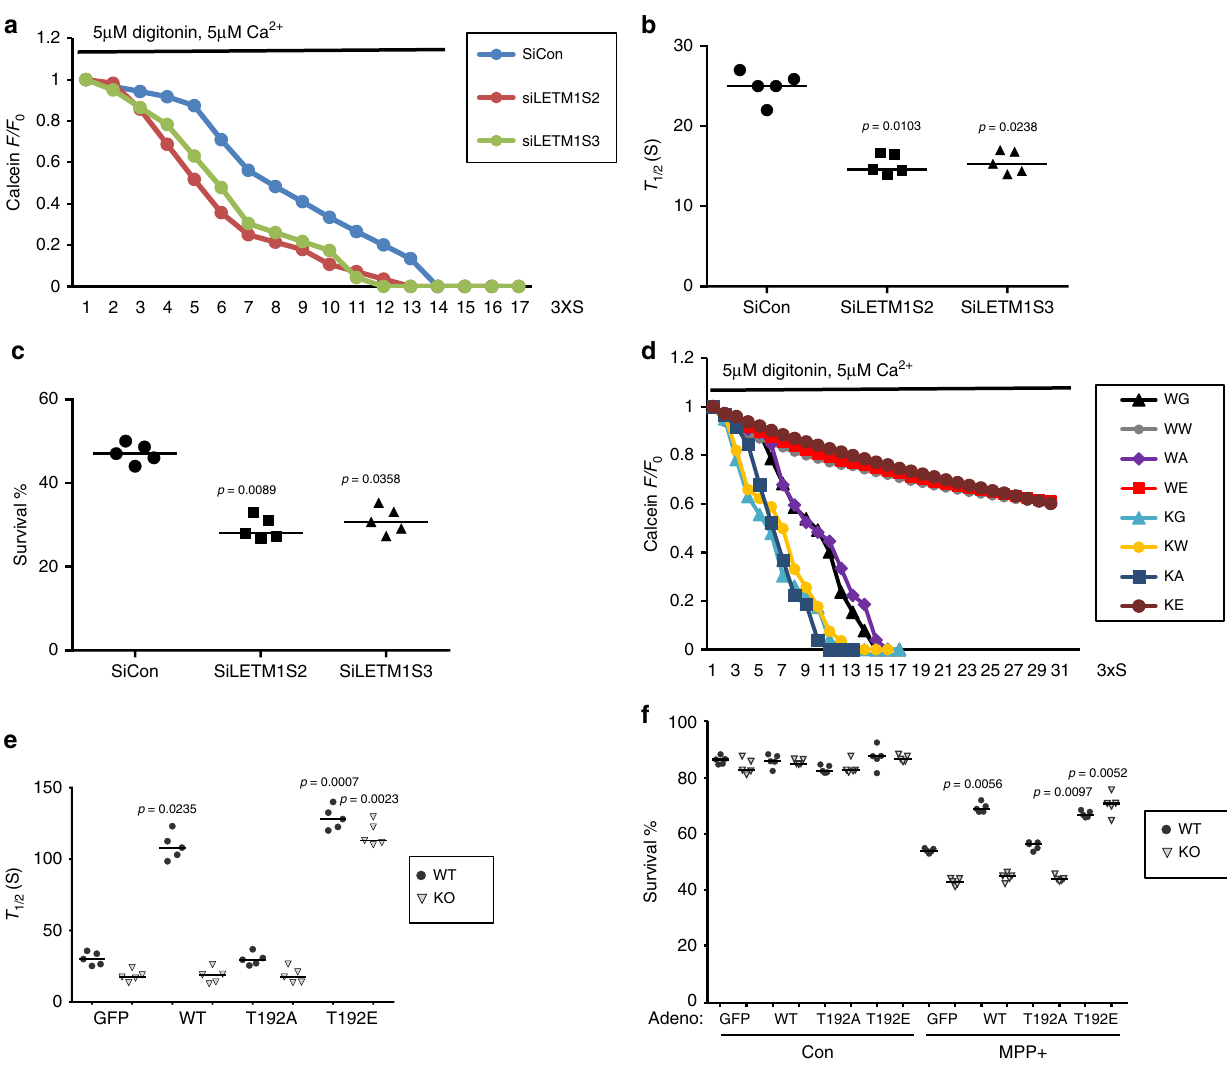
Fig. 5 The protective role of phospho-LETM1 at Thr192 in mPTP opening and neuronal death. a , b Primary cortical neurons were transfected with control SiCon, SiLETM1-S2, and -S3 and then were processed to calcium-induced mPTP opening assay. a Representative average calcein fl uorescence traces of neurons are presented. b Half-life time was calculated for groups in a . n = 5. c Survival assay was performed in siRNA-treated neurons. n = 5. d Cortical neurons from PINK1 WT were infected with lenti-mitoCherry (WC), LETM1-Cherry WT (WW), T192A (WA), or T192E (WE) or from PINK1 KO were also infected with lenti-mitoCherry (KC), LETM1-Cherry WT (KW), T192A (KA), or T192E (KE) for 5 days and then were processed to calcium-induced mPTP opening assay. Representative average calcein fl uorescence traces of neurons are presented. n = 5. e Half-life time was calculated for groups in d . n = 5. f Primary cortical neurons from PINK1 WT and KO were infected with adenovirus expression GFP, LETM1-WT, T192A, or T192E and then treated with 75 µ M MPP+ or saline for 24 h at DIV3. Neuronal survival was evaluated after MPP+ or saline treatment. n = (Fig. 5f). However, only expression of LETM1-T192E in PINK1 KO neurons resulted in protection against calcium-induced mPTP opening (Fig. 5d, e) and MPP + challenge (Fig. 5f). Simi- lar fi ndings were observed in an in vivo MPTP model. We examined the effects of expression of adenoviral GFP, LETM1- WT, T192A, and T192E in DA neuronal loss in MPTP injected mice. We veri fi ed the expression of LETM1 and its mutants in the substantia nigra pars compacts (SNc) of mice by WB (Supple- mentary Fig. 12a) and immuno fl uorescence (Supplementary Fig. 11b) after adenoviral injection. In the saline-injected control Fig. 11a, b) and knockdown of LEMT1 by SiLETM1-S2 and group, expression of adeno-LETM1-WT and T192A and T192E -S3 sensitized cultured neurons to calcium-induced mPTP did not lead to signi fi cant neuronal death in the SNc of WT and opening (Fig. 5a, b) and MPP + treatment (Fig. 5c). Second, KO mice (Fig. 6a, b). Expression of LETM1-WT and T192E but expression of LETM1-WT and LETM1-T192E but not LETM1- not T192A signi fi cantly protected DA neurons from loss com- T192A or GFP control in PINK1 WT neurons protected against pared to the GFP control in PINK1 WT mice, whereas only calcium-induced mPTP opening (Fig. 5d, e) and MPP + challenge expression of LETM1-T192E but not WT and T192A protected